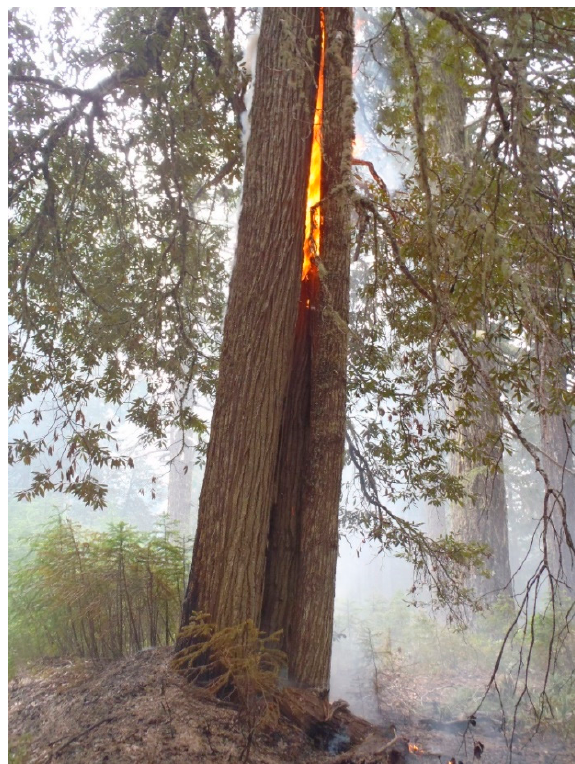
Figure 11. During a prescribed burn in June 2017, fire entered the cavity of this large chinquapin tree, which compromised its integrity (Photo credit: Frank K. Lake).